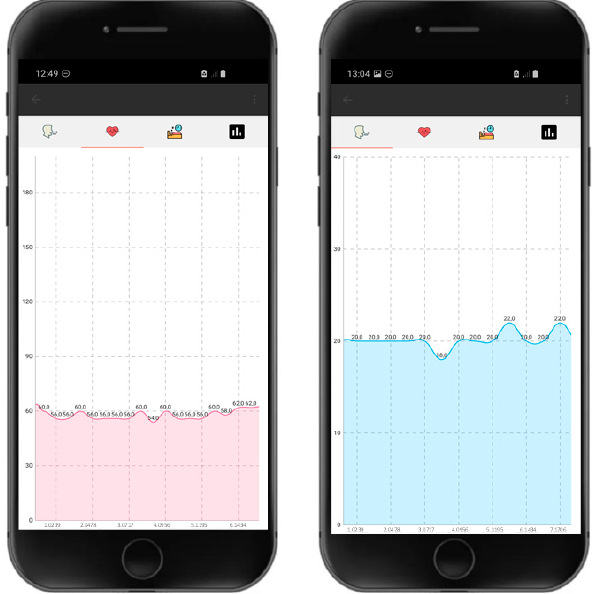
Figure 3. Screen captures of the custom-developed Android application showing examples of plotted data corresponding to heart rate (left) and breath rate (right).